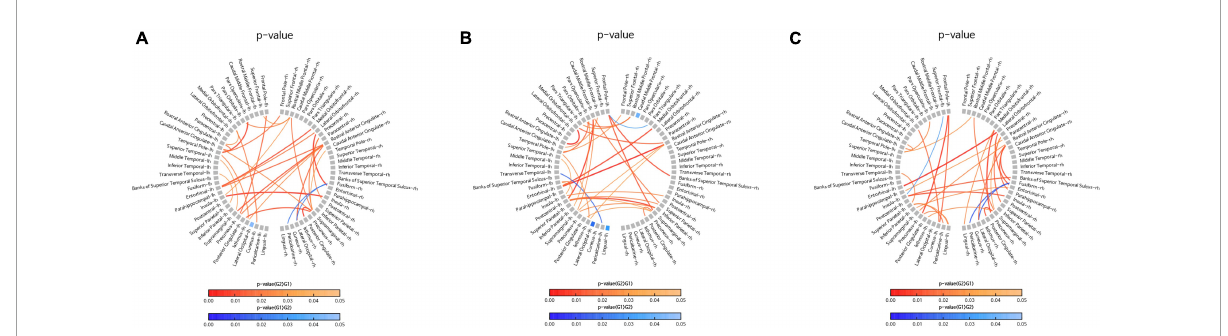
FIGURE3 Comparison of changes in the imaginary part of coherence (iCoh) of the alpha1 band. Regions with significant differences in the iCoh changes between two groups are shown in the figures. Red lines represent a significant increase in the iCoh of the alpha1 band in the intervention group (G2) than in the control group (G1). Blue lines represent a significant increase in the iCoh of the alpha1 band in the control group (G1) than in the intervention group (G2). (A) Comparison of the control group (G1) with all intervention groups (G2), including facility-based multidomain intervention (FMI) and home-based multidomain intervention (HMI) groups. (B) Comparison of the FMI group (G2) with the control group (G1). (C) Comparison of the HMI group (G2) with the control group (G1).